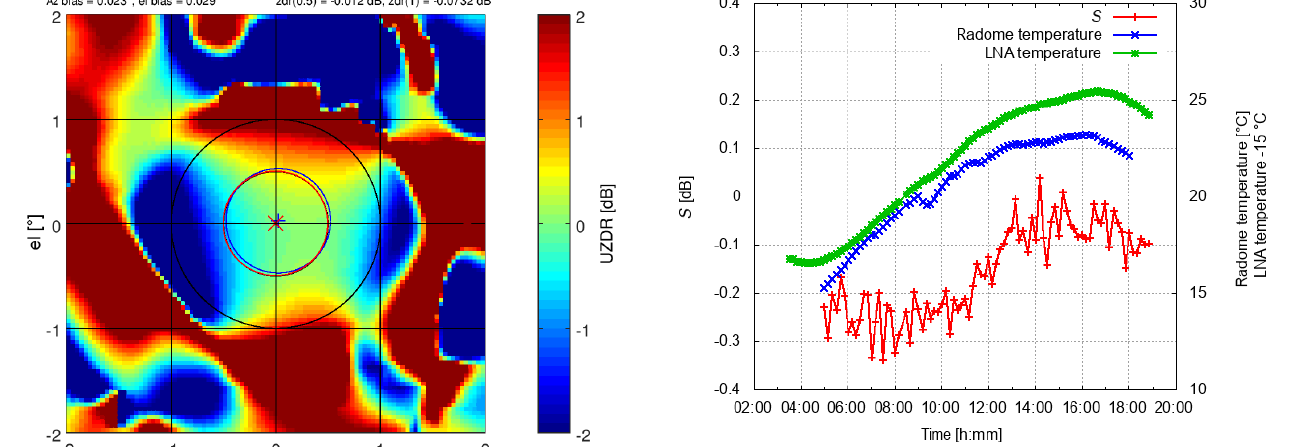
Figure 8. Variability in differential solar power S [dB] on 15 June 2018 (UTC). Also shown is the radome temperature and the temperature near the LNA in the receiver